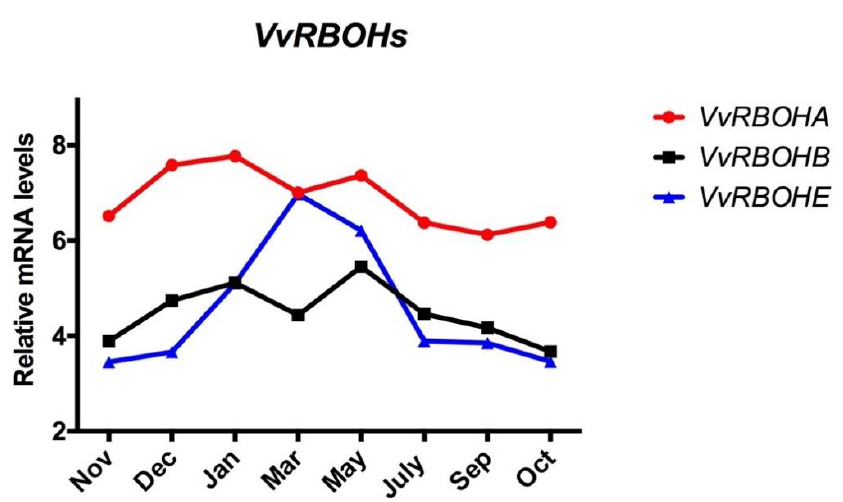
Figure 3. Expression profile of RESPIRATORY BURST OXIDASE HOMOLOGS ( VvRBOHs ) genes in grapevine buds during endodormancy. The expression profile of VvRBOH genes in Tempranillo grapevine buds grown in Alcalá de Henares, Madrid [21] and adapted to the Southern Hemi- sphere conditions.